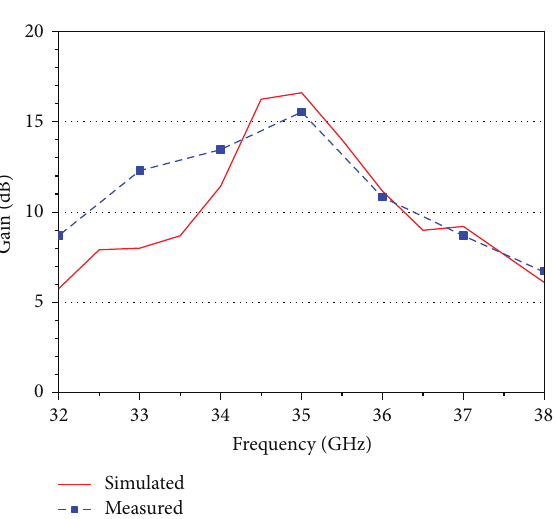
Figure 10: Simulated and measured gains.